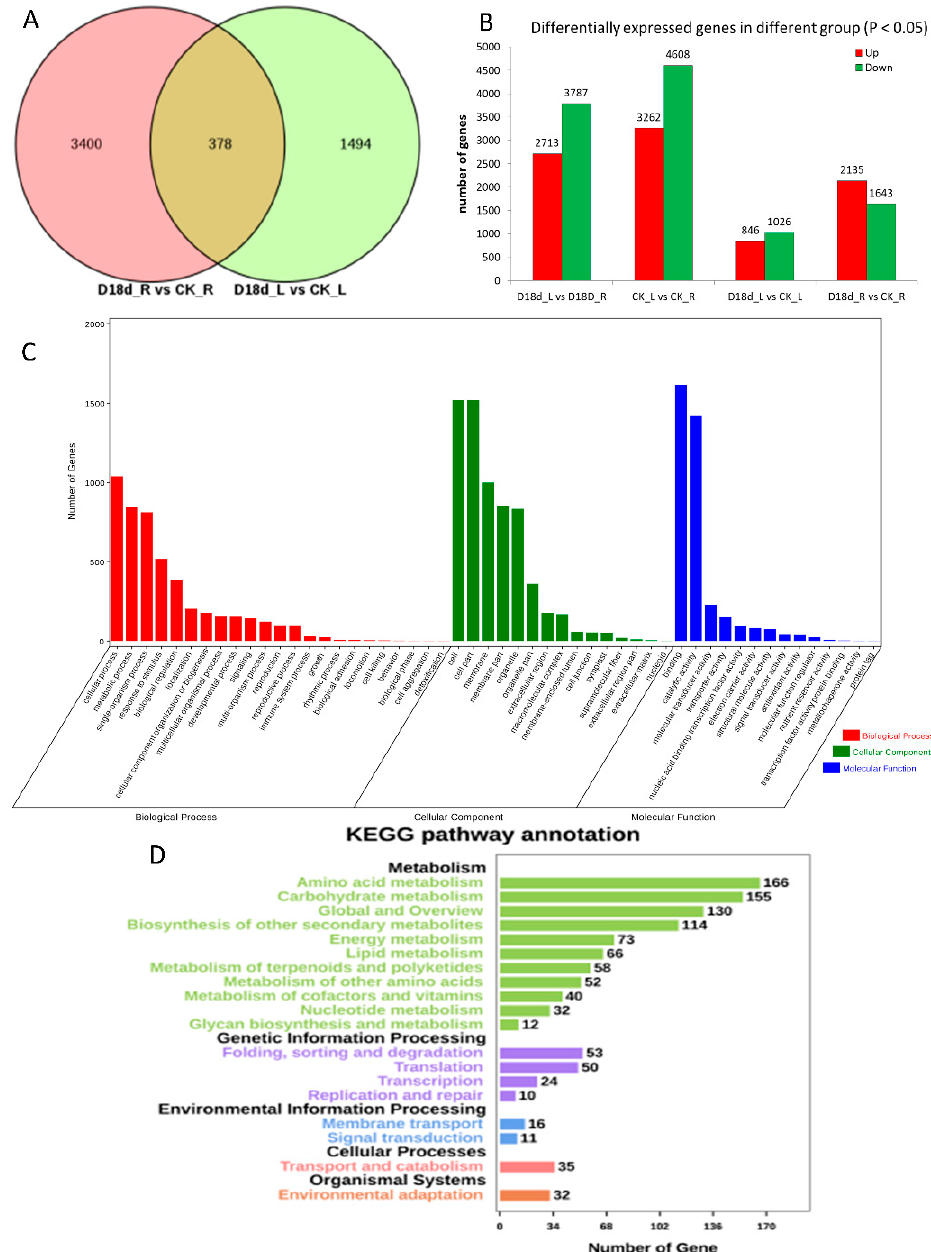
Figure 1. Differentially expressed genes (DEGs) in orchardgrass treated with drought stress. ( A ) Venn diagram of DEGs from root and leaf after drought treatment; pink color represent to comparison of drought treat root to controlled root, light-yellow color represent to comparison of drought treat leaf to controlled leaf; ( B ) column graph of DEGs in different treatment groups showing both upregulated and downregulated genes; ( C ) gene ontology annotation for all 5272 DEGs; ( D ) Kyoto encyclopedia of genes and genomes pathway annotation for all 5272 DEGs.